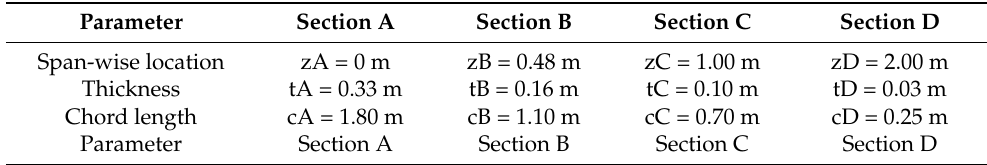
Table 2. Characteristic sectional airfoil